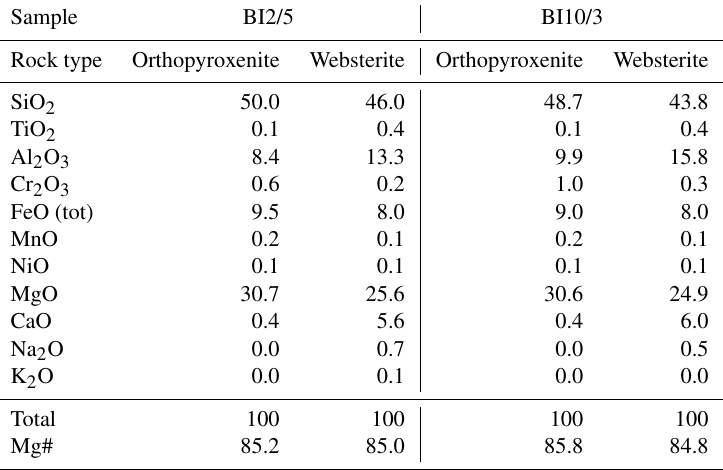
Table A2. Computed whole-rock compositions of orthopyroxenite and websterite micro-layers occurring along the contact between peri- dotites and crosscutting gabbronorite dykes BI2/5 and BI10/3. Calculations were carried out based on mineral (Tables 3–6) and modal com- positions (Table 10). Volume mineral proportions were converted to weight mineral proportions based on the following densities: